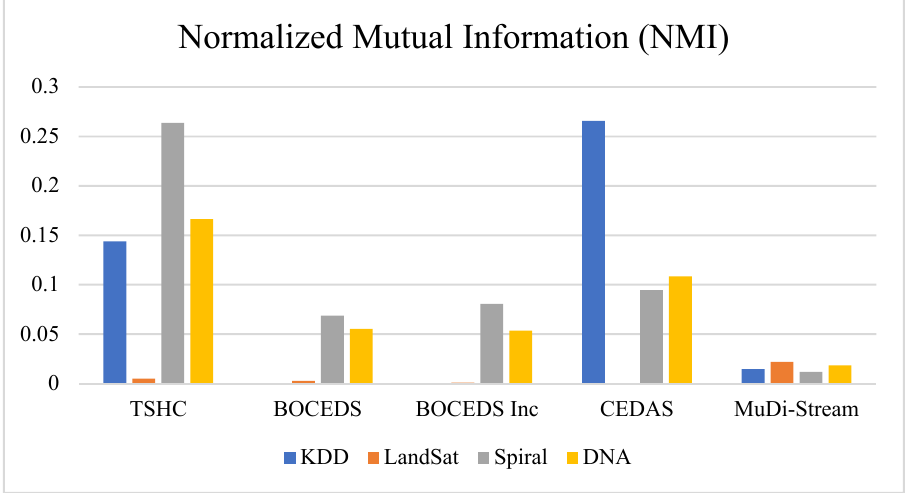
Figure 7. Normalized Mutual Information Comparison Using KDDCup’99, Landsat, Spiral, and DNA Datasets.